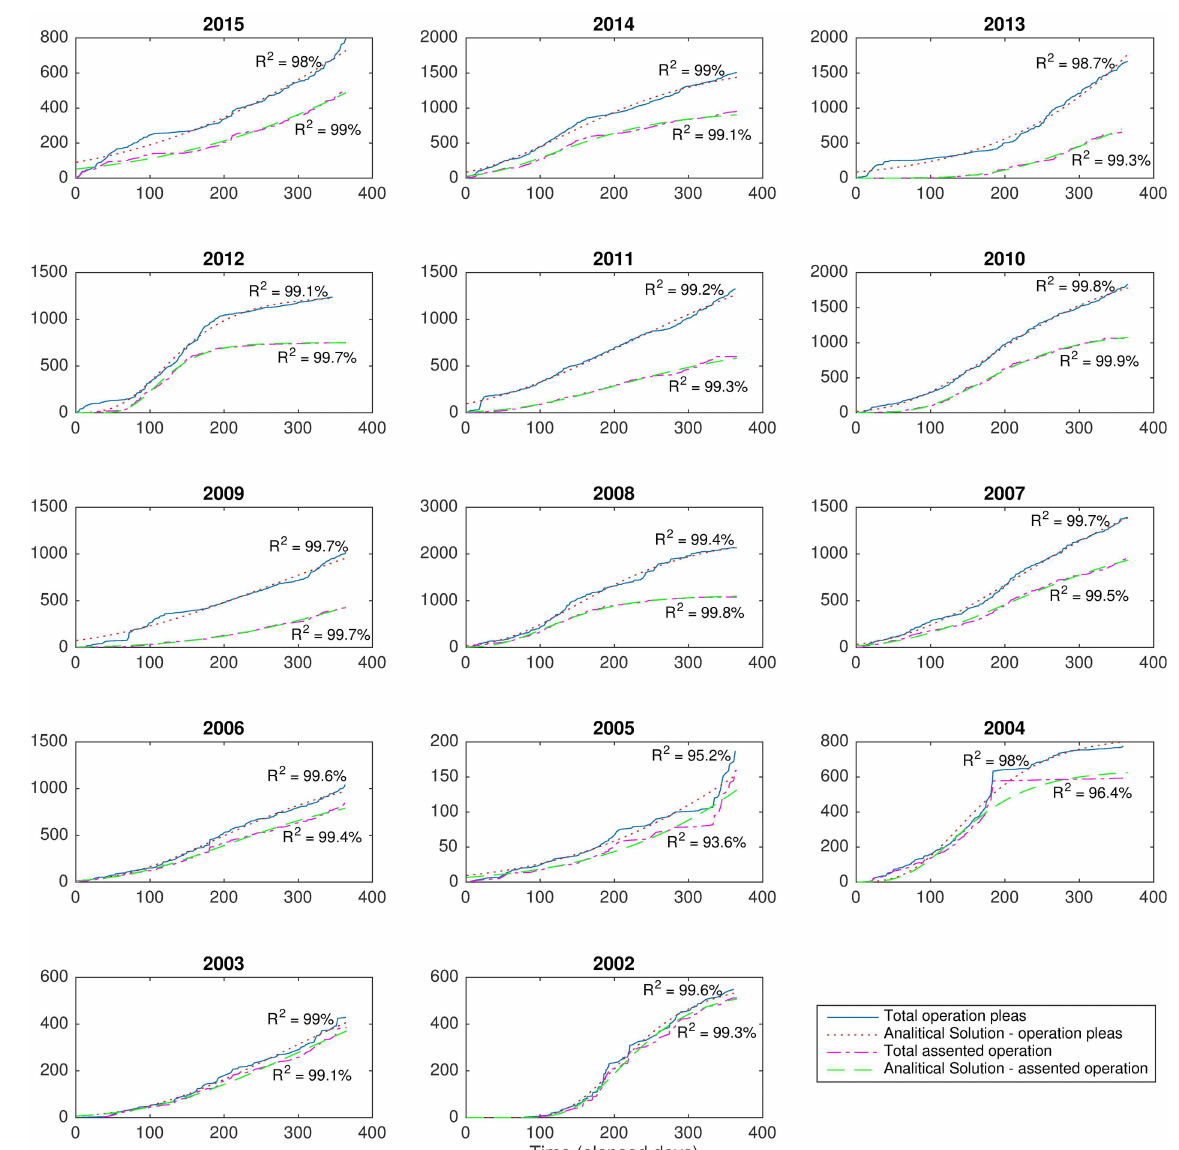
Fig 3. Demonstration that the amount of public credit pleas per year follows a sigmoid diffusion process. Each plot shows the total number of credit operationpleas and the total number of operations that were assentedin Brazil, yearly. For each line, the corresponding analytic solution obtained from the derivedGompertz model is shown. Accuracy of the analytic solutionswere measuredin terms of R 2